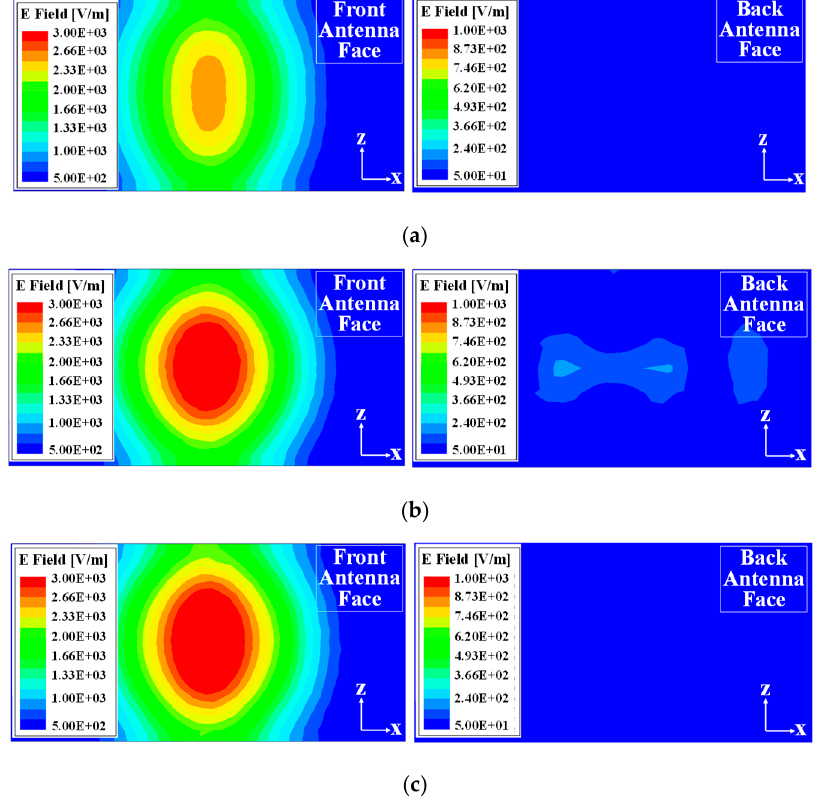
Figure 4. The electric field in the x–z plane at the front and back faces of the dipole antenna. ( a ) With